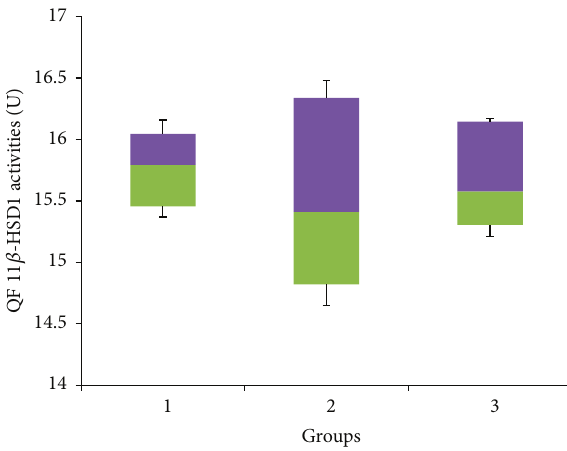
Figure 15: 11 𝛽 -HSD 1 activities in the quadriceps femoris of rats in group A, B, and C at the end of the four-week treatment period. Group A: control (HSD/HFD); group B: stress + HSD/HFD; group C: stress + GA + HSD/HFD. Abbreviations: GA: glycyrrhizic acid, HSD: high-sucrose diet, and HFD: high-fat diet.